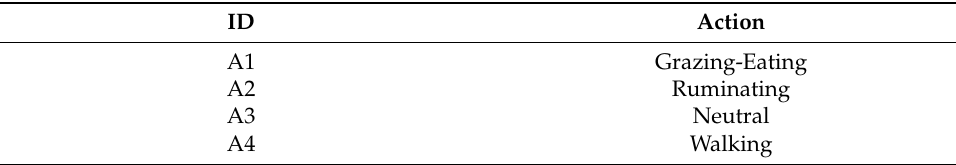
Table 4. General behaviour annotations.